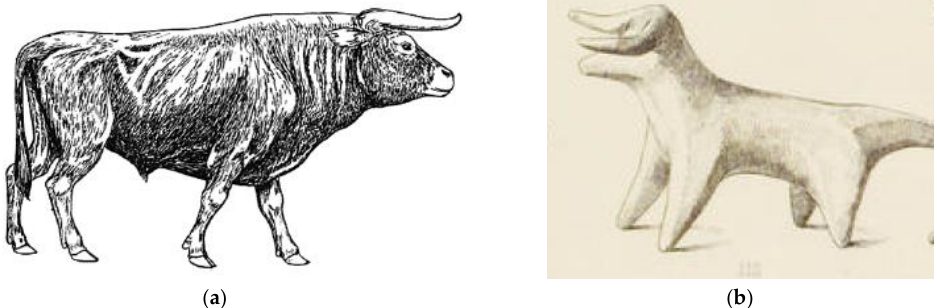
Figure 2. ( a ) Bos primigenius (Bojanus 1827); ( b ) Olympia B 5137 after Furtwängler (1890, Pl. X fig. 112).